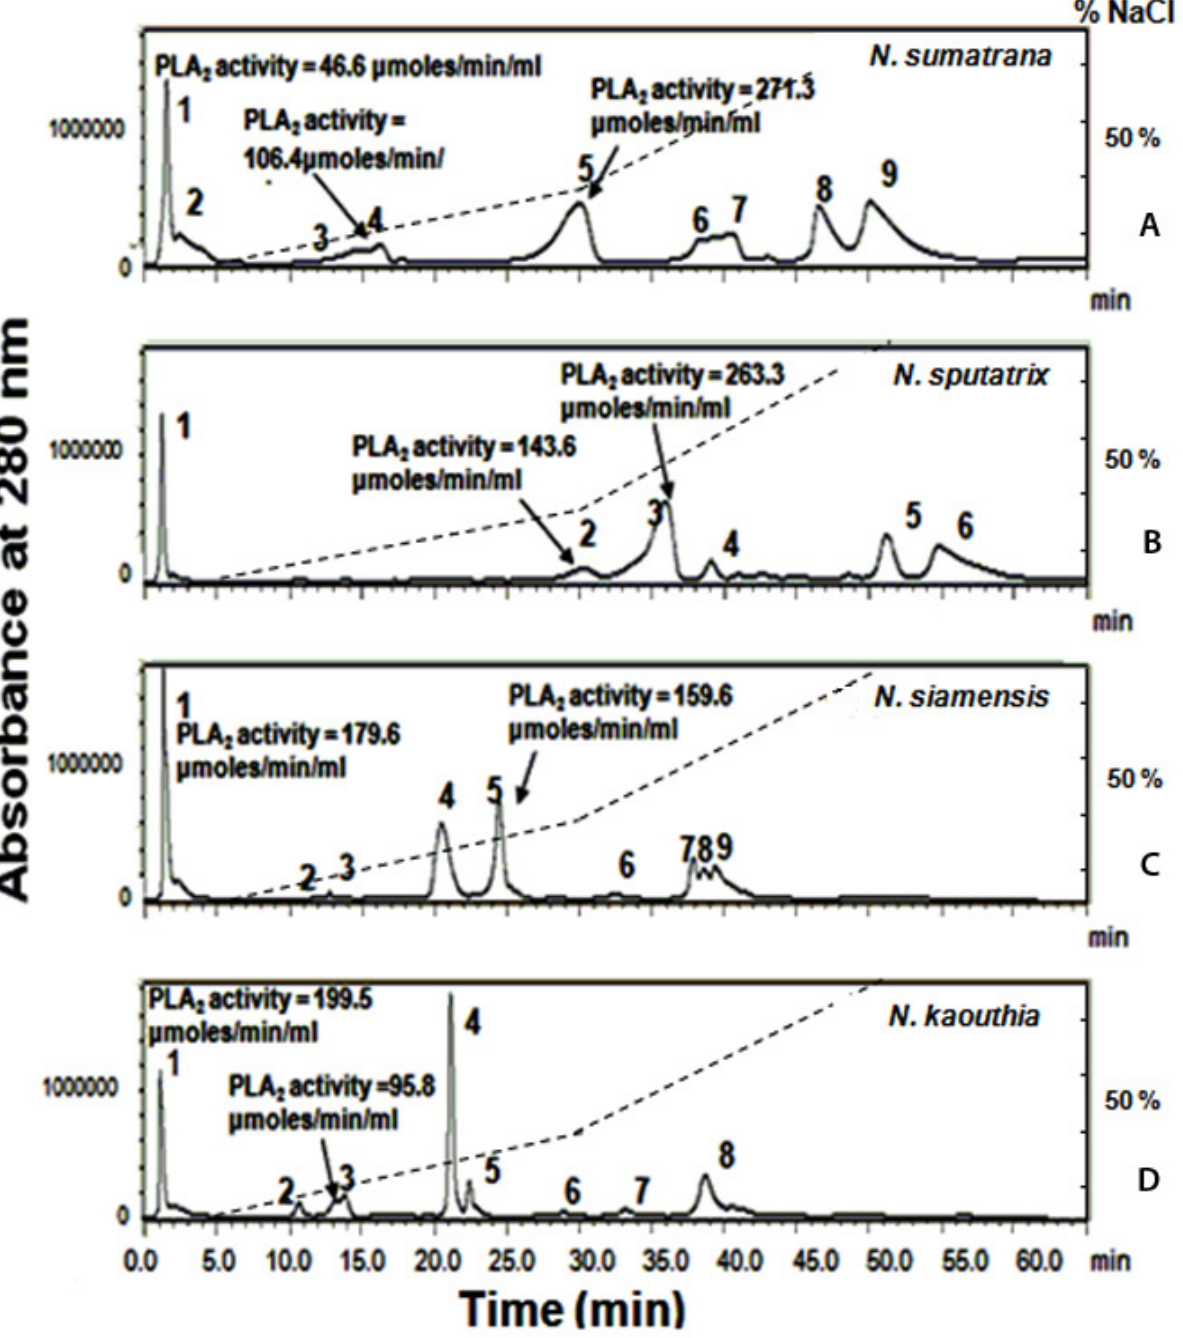
Figure 2. Fractionation of four Southeast Asian cobra venoms by Resource® S cation exchange chromatography. Ten milligrams of the venom was injected into the column equilibrated with 20 mM MES, pH 6.0, and eluted by a linear gradient (0 to 0.8 M NaCl of 0-30 % from 5 to 30 minutes, followed by 30-100% from 30-55 minutes). Flow rate was 1 mL/minute. Dotted line: gradient of elution. The venoms were from: ( A ) N. sumatrana ; ( B ) N. sputatrix ; ( C ) N. siamensis and ( D ) N.